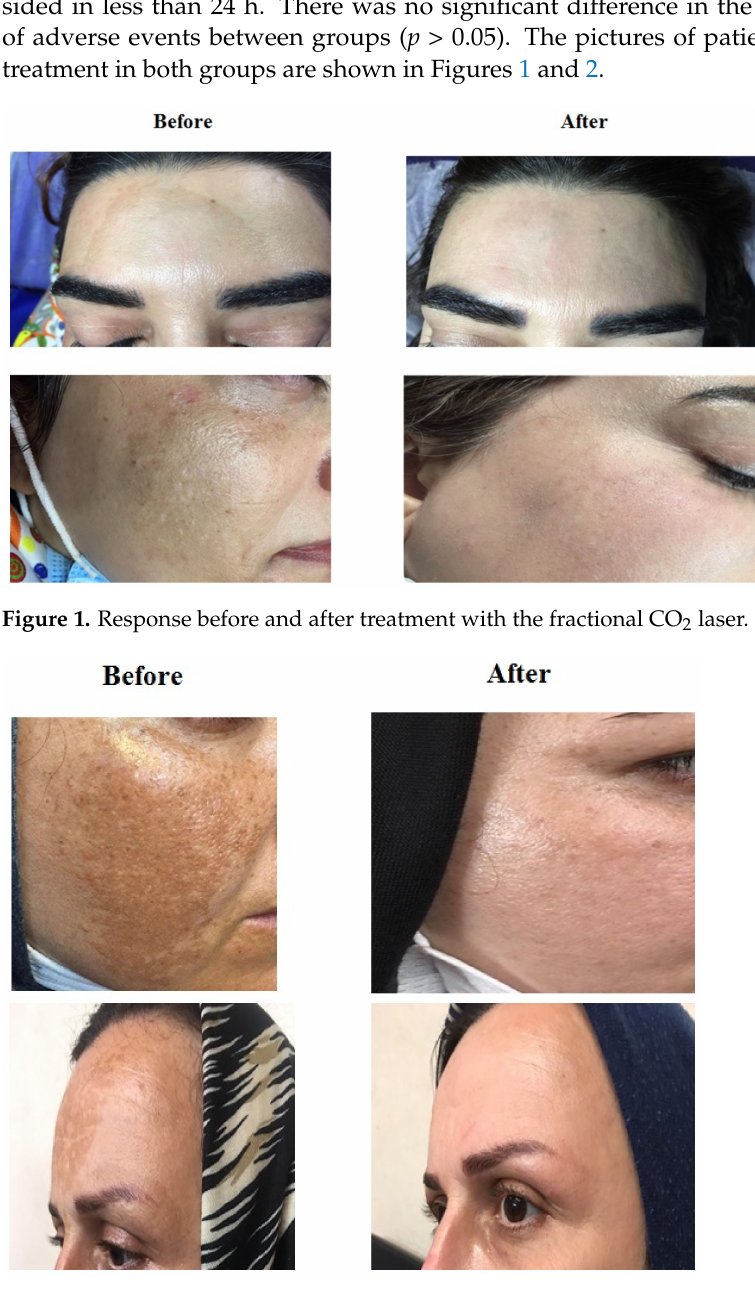
Figure 2. Response before and after the Q-Switched Nd:YAG (QSNY)